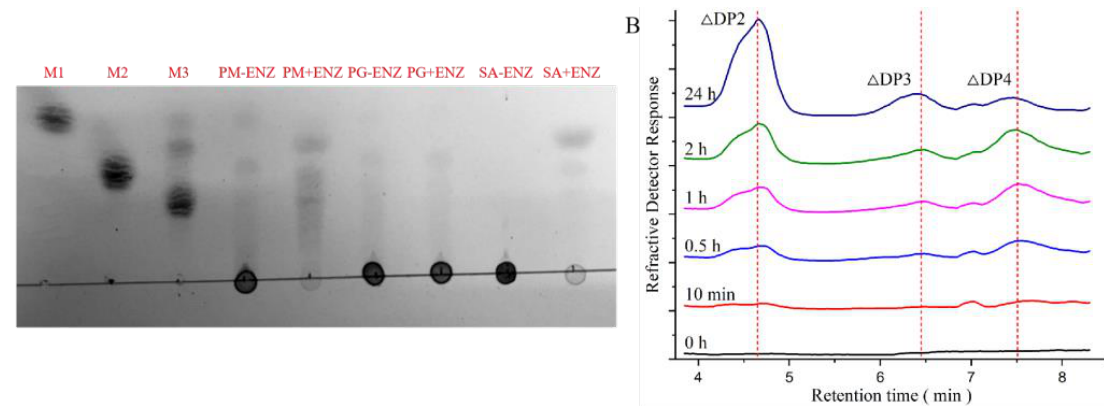
Figure 6. Product analysis of the novel alginate lyase (PMD). ( A ) Thin-layer chromatography (TLC) analysis of the final degraded products (6 h) by PMD (M1: mannuronic acid monomer, M2: mannuronic acid dimer, mannuronic acid trimer, +ENZ: with PMD, -ENZ: without PMD, SA: sodium alginate); ( B ) liquid chromatography (LC) analysis of the degraded products (sodium alginate used as substrate) by PMD ranging from 0 h to 24 h (peak ∆DP2: disaccharides, peak ∆DP3: trisaccharides, peak ∆DP4: tetrasaccharides).